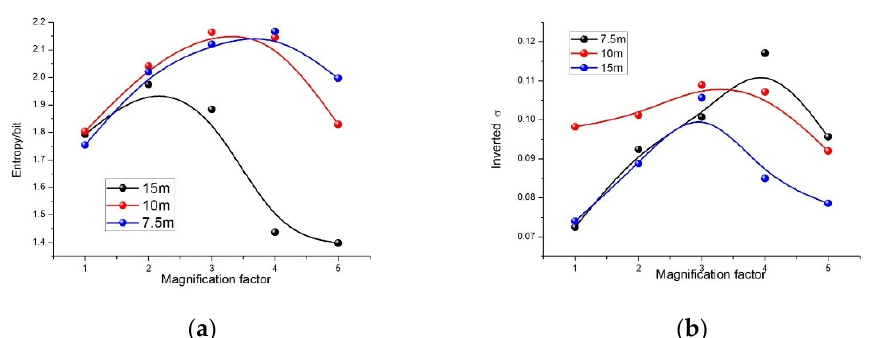
Figure 11. ( a ) Relation between entropy and magnification factor of the reconstructed DOP images. ( b ) Relation between the inverted σ and magnification factor of the reconstructed polarization images.